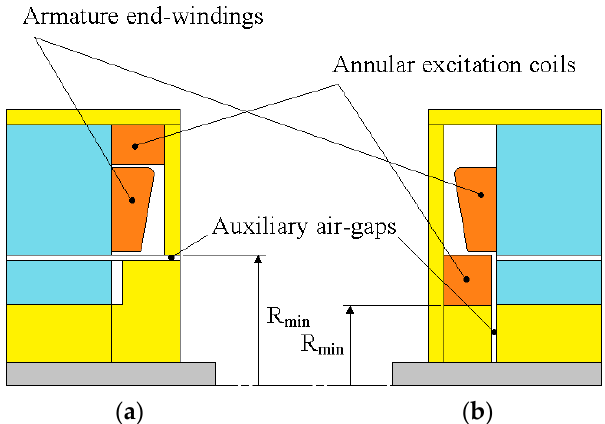
Figure 11. Annular excitation coils location. ( a ) Above armature end-windings; ( b ) below armature end-windings.